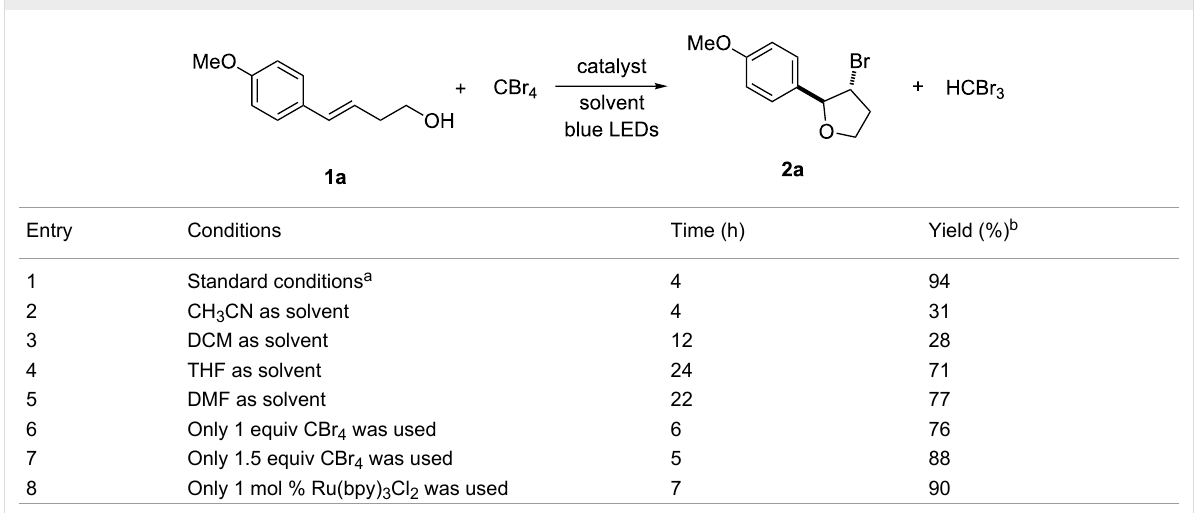
Table 1: Survey on the photocatalytic bromoetherification of alkenols.